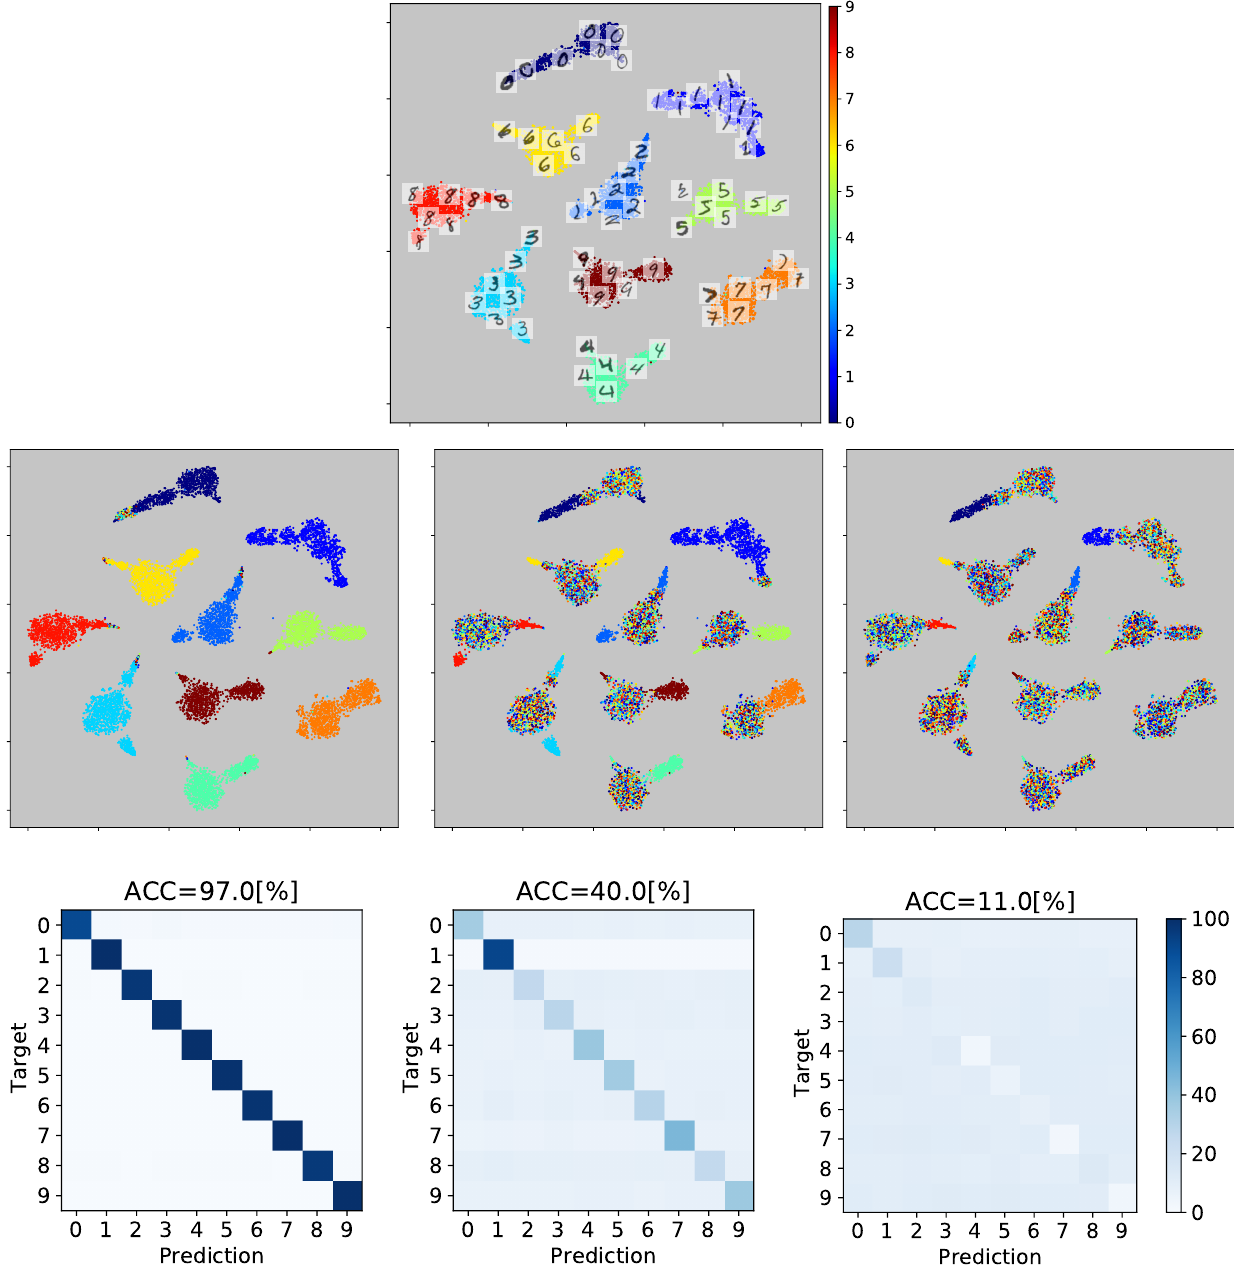
Figure 6. Simulated annotators’ for the MNIST database. A 2D t-SNE-based projection of the Mnist training set from the FC1 layer feature maps is shown (some exemplary images are depicted over their 2D projections, where numbers from zero to nine stand for each MNIST class). The ground truth labels are used as a color. The second row depicted the 2D projection of each annotator’s labels in color. The third row presents the confusion matrix of each expert and their achieved